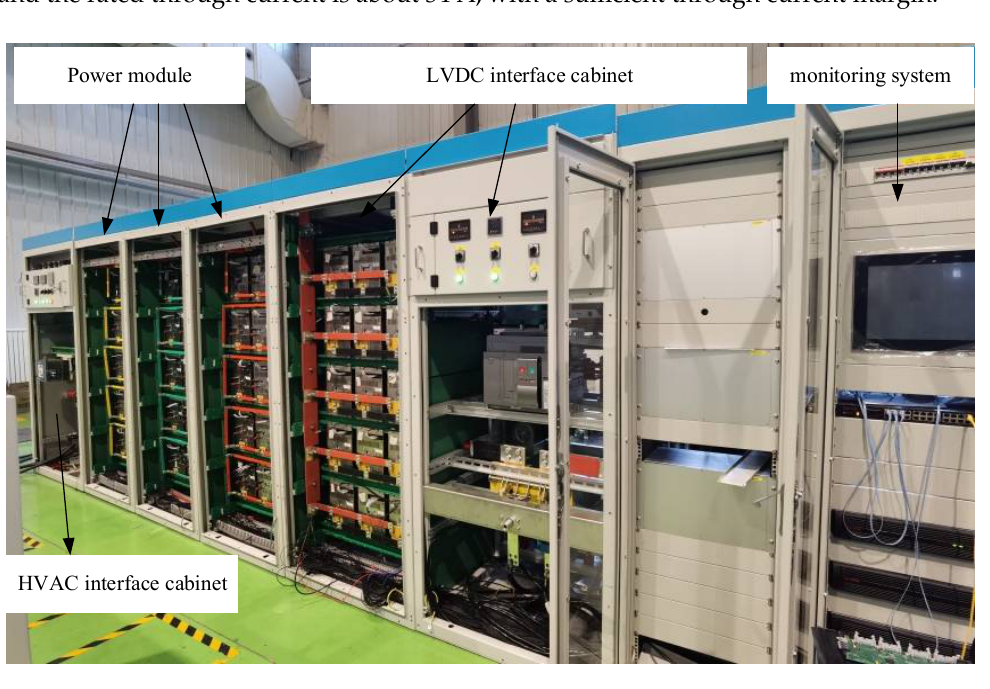
Figure 15. PCS prototype.